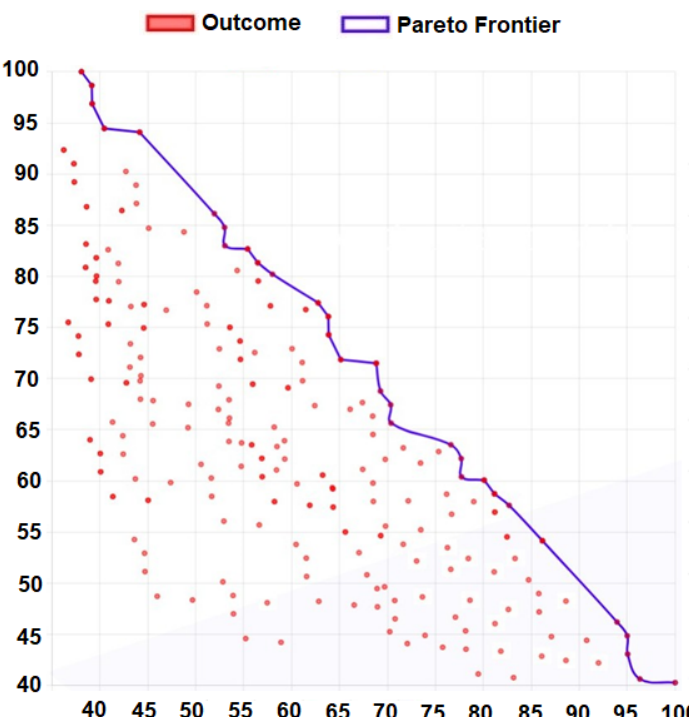
Figure 5. Outcome Space.